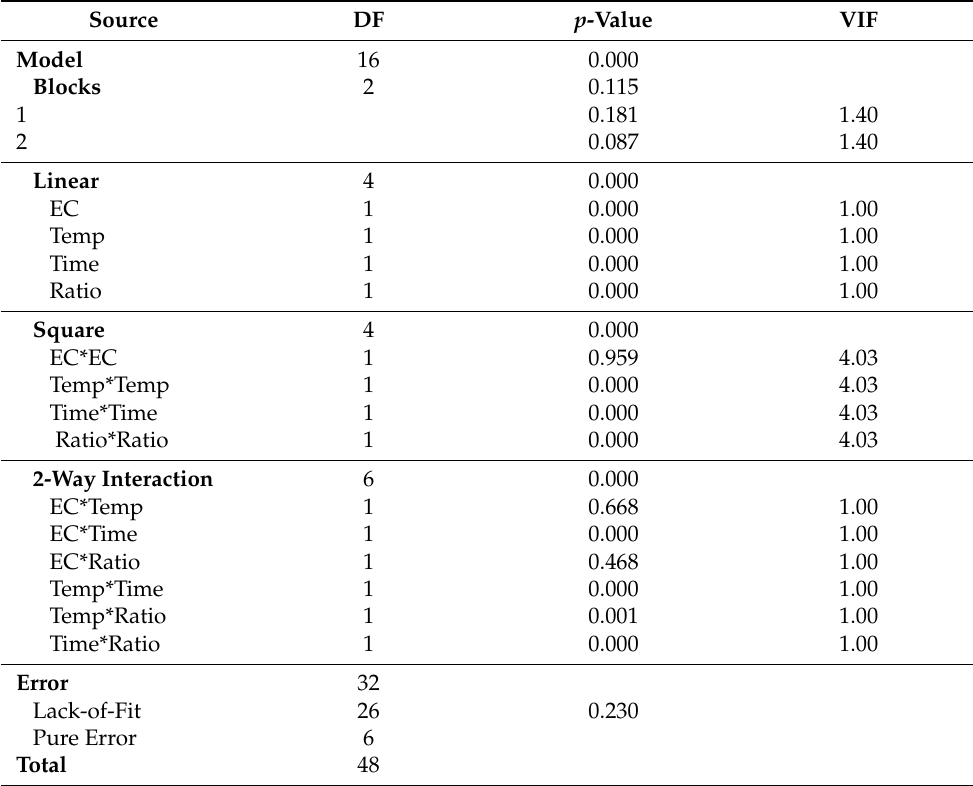
Table 2. Analysis of variance on biodiesel conversion